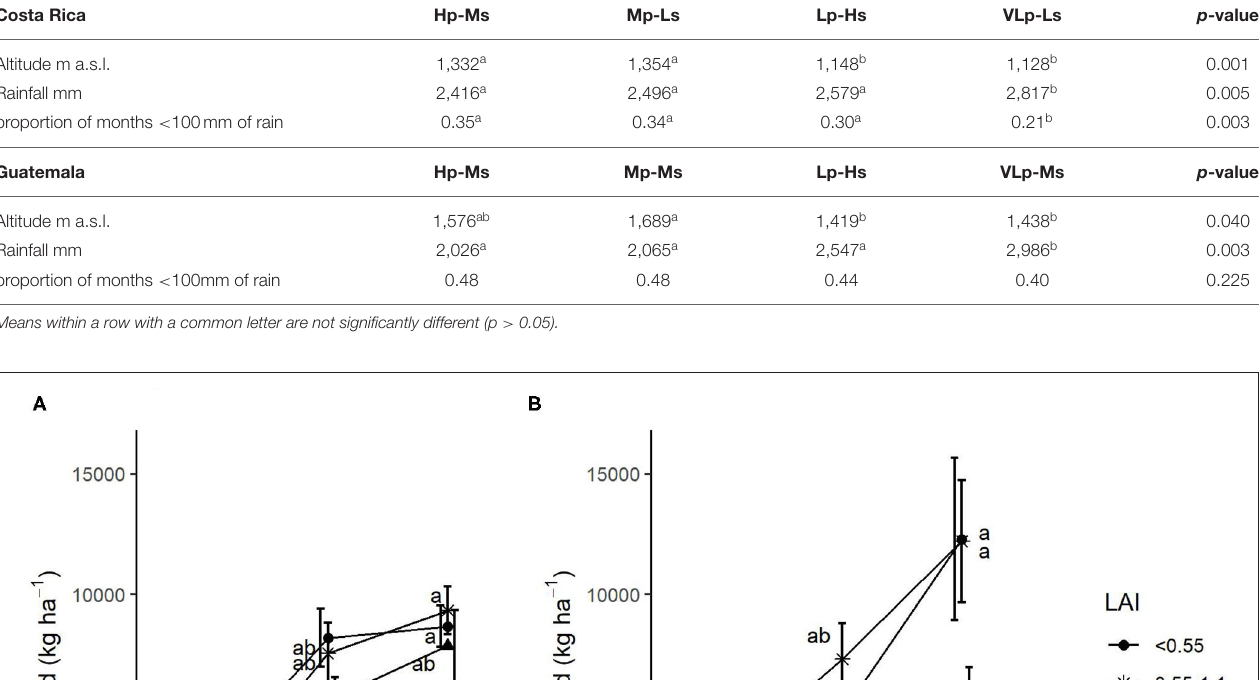
TABLE 5 | Agri-environmental conditions for each coffee plantation typology (key to typology codes see Table 2 ). Costa Rica Hp-Ms Mp-Ls Lp-Hs VLp-Ls p -value Altitude m a.s.l.